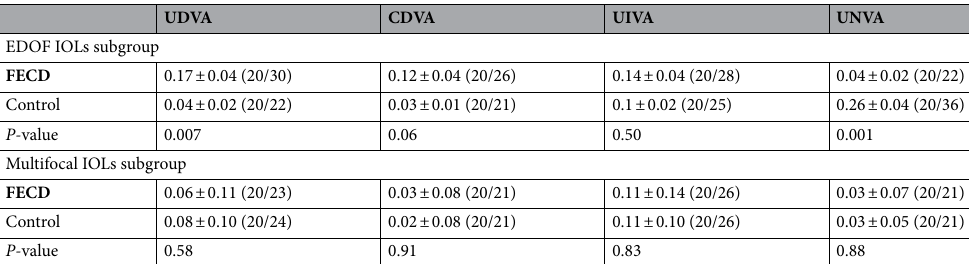
Table 4. Visual acuity results. The visual acuity results are displayed as mean ± SD in LogMAR and Snellen in parentheses. IOLs intraocular lenses; EDOF extended depth of focus; FECD Fuchs endothelial corneal dystrophy; UDVA uncorrected distance visual acuity; CDVA corrected distance visual acuity; UIVA uncorrected intermediate visual acuity; UNVA uncorrected near visual acuity. UIVA for the multifocal IOLs subgroup consisted of trifocal IOLs